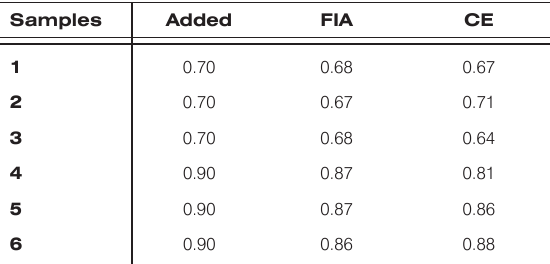
Table 6. ETB content expressed in mmol L -1 for synthetic urine samples obtained from FIA and CE.